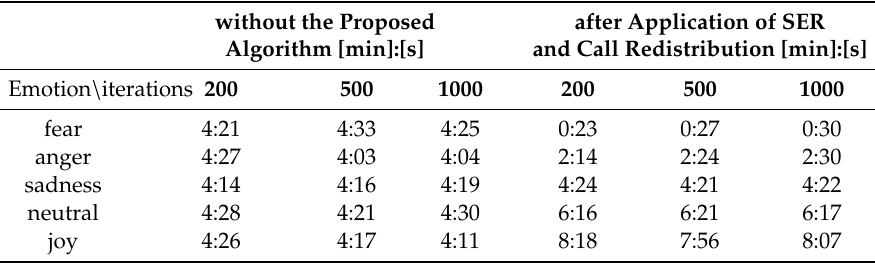
Table 7. Average waiting time when 5 calls are received simultaneously while all operators are busy. without the Proposed